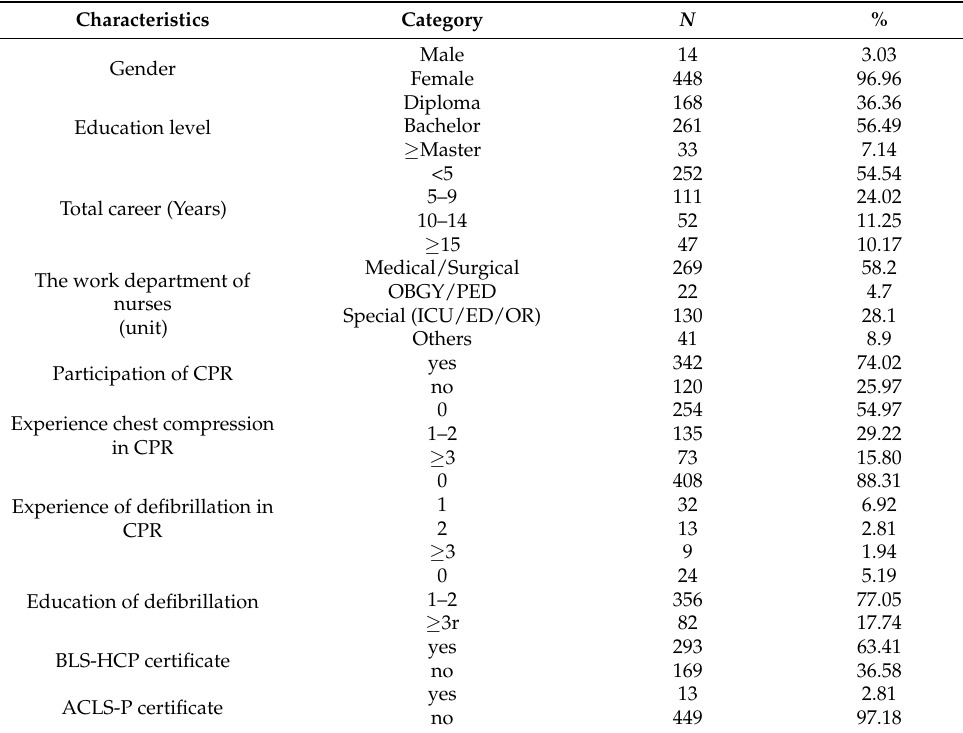
Table 1. General Characteristics of Clinical Nurses ( N =